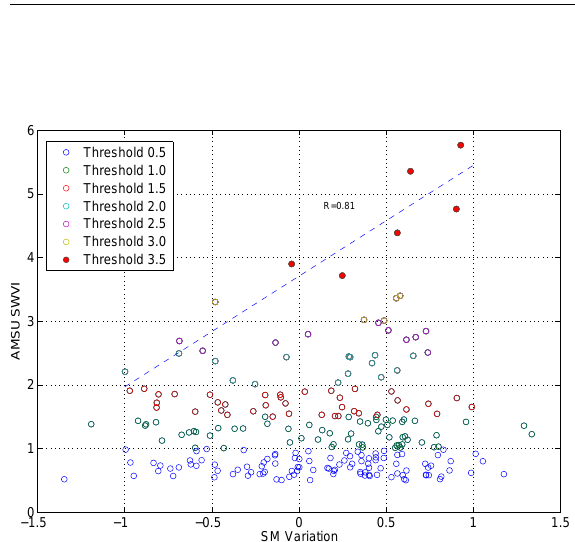
Fig. 8. Comparison between the variation of the simulated SM (m 3 m − 3 ) and the AMSU based SWVI (–) index exceeding the thresholds ranging from 0.5 to